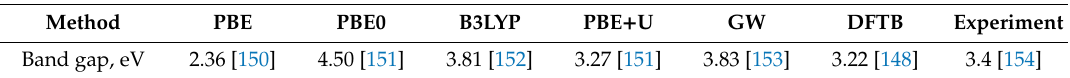
Figure 12. Energy level diagram (eV) of anatase, rutile, and SrTiO 3 nanoparticles according to [98,147]. CB and VB stand for conduction band and valence band, respectively. Table 1. Electronic band gap for bulk anatase TiO 2 . Self-consistent charge density functional tight-binding (SCC-DFTB) values have been compared to the experimental data, values calculated with standard GGA-DFT, with hybrid DFT functionals, GGA-DFT Hubbard corrected and post-Hartree–Fock GW approximation